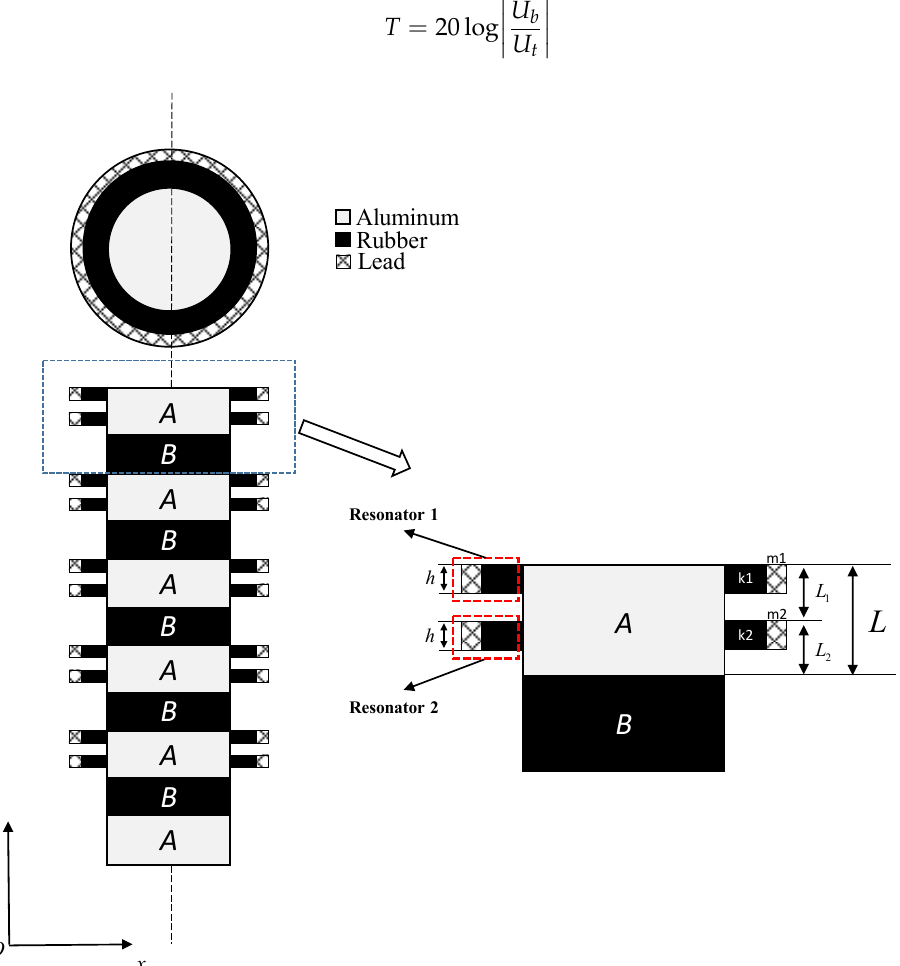
Figure 4. Schematic representation of a finite coupling periodic strut.